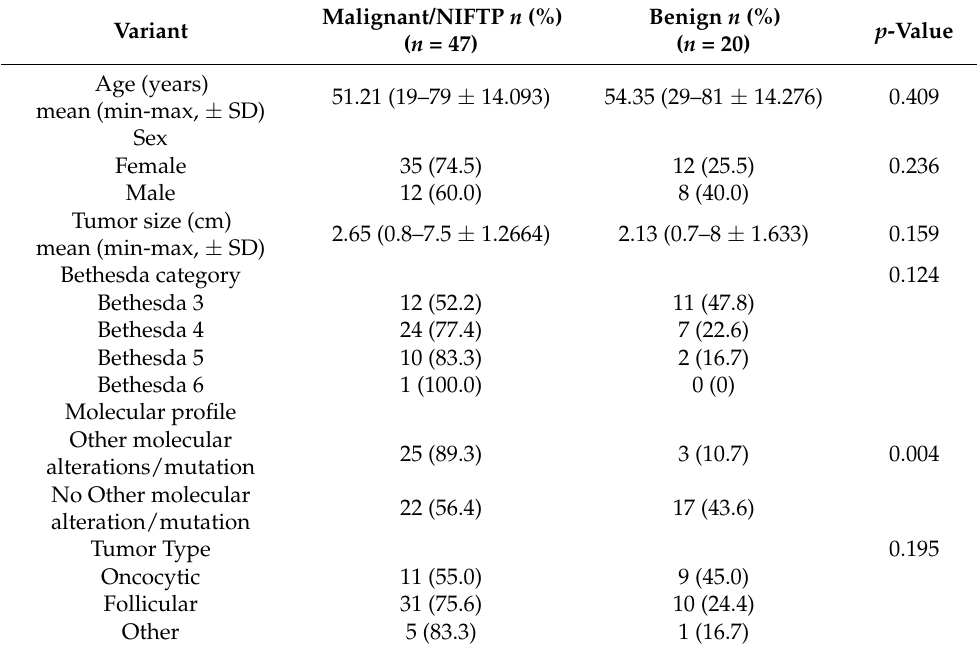
Table 2. Association between malignancy and clinicopathological characteristics in the 67 patients with CNA-positive thyroid nodules that underwent surgery.